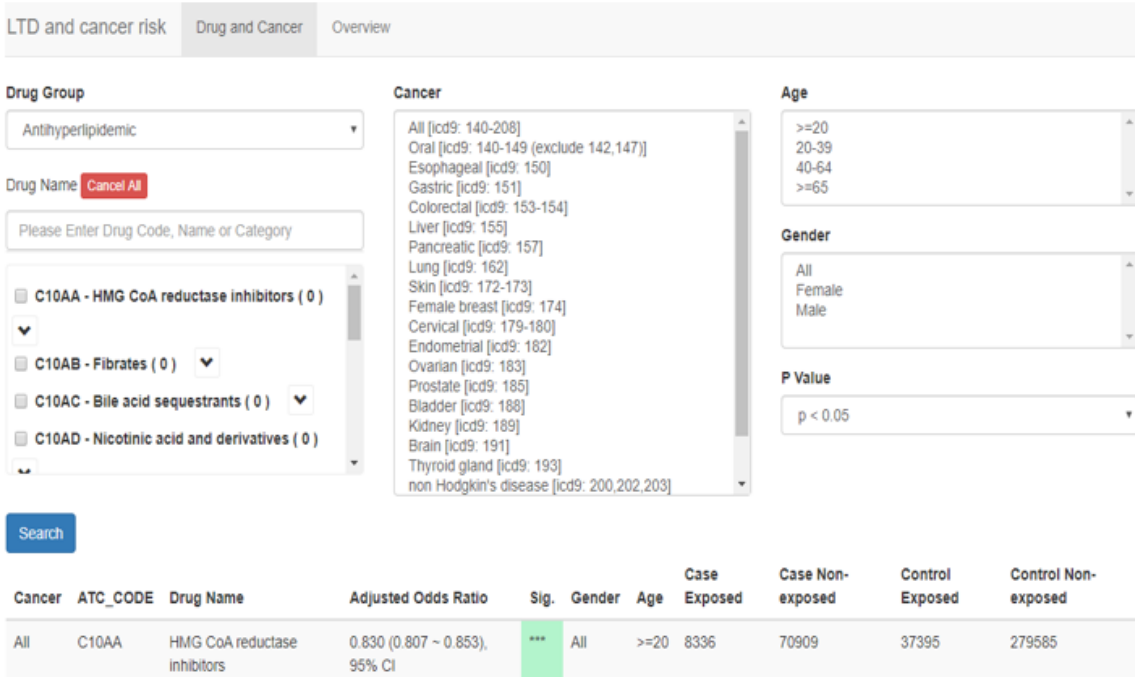
Figure 3. Display of drug and cancer